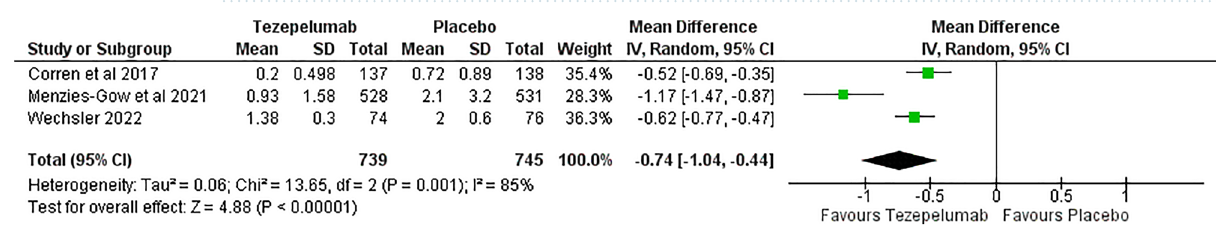
Figure 3. Risk of bias summary for randomized controlled trials using ROB2.